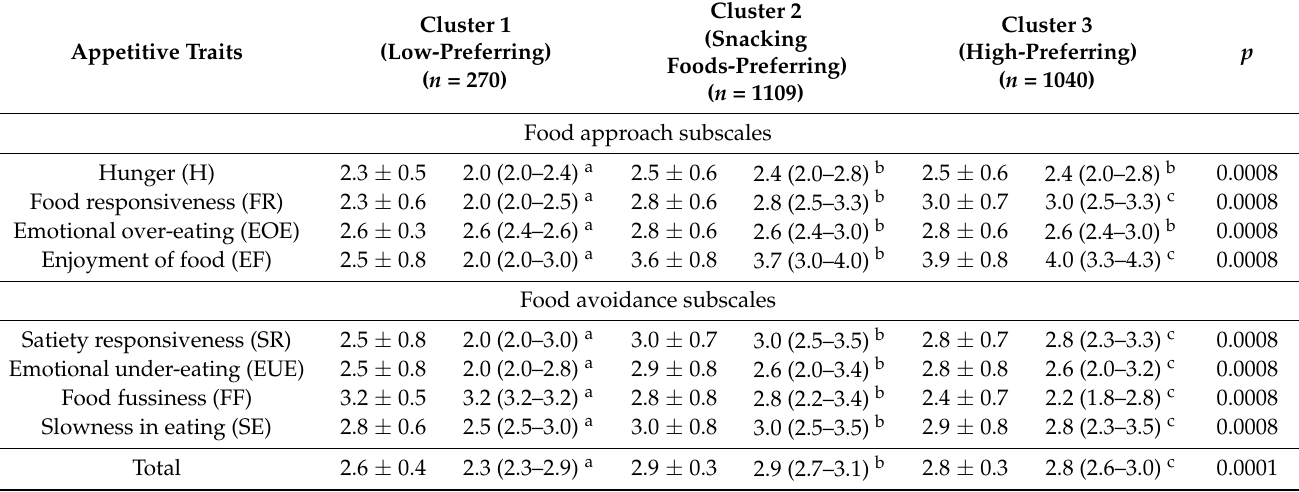
Table 4. The appetitive traits assessed by Adult Eating Behavior Questionnaire (AEBQ) for sub-groups stratified based on the clustering of the preferences assessed by Food Preference Questionnaire (FPQ) within the population of the second phase of the Polish Adolescents’ COVID-19 Experience (PLACE-19) Study ( n = 2419) (distribution different than normal for all the variables verified using Shapiro-Wilk test— p ≤